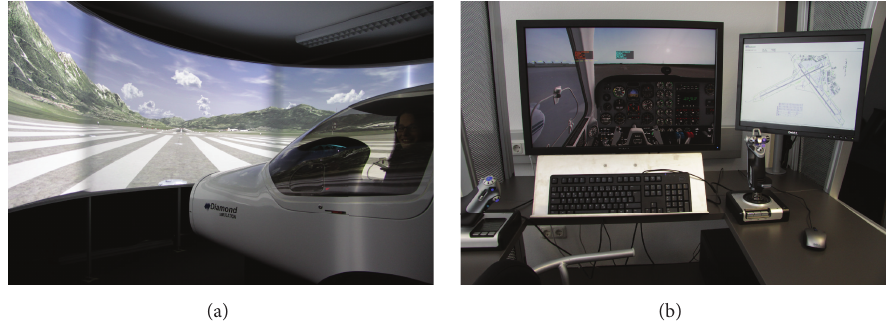
Figure 16: (a) Diamond DA-42 flight simulator and (b) X-Plane flight simulator coupled with X23 into the EDDH